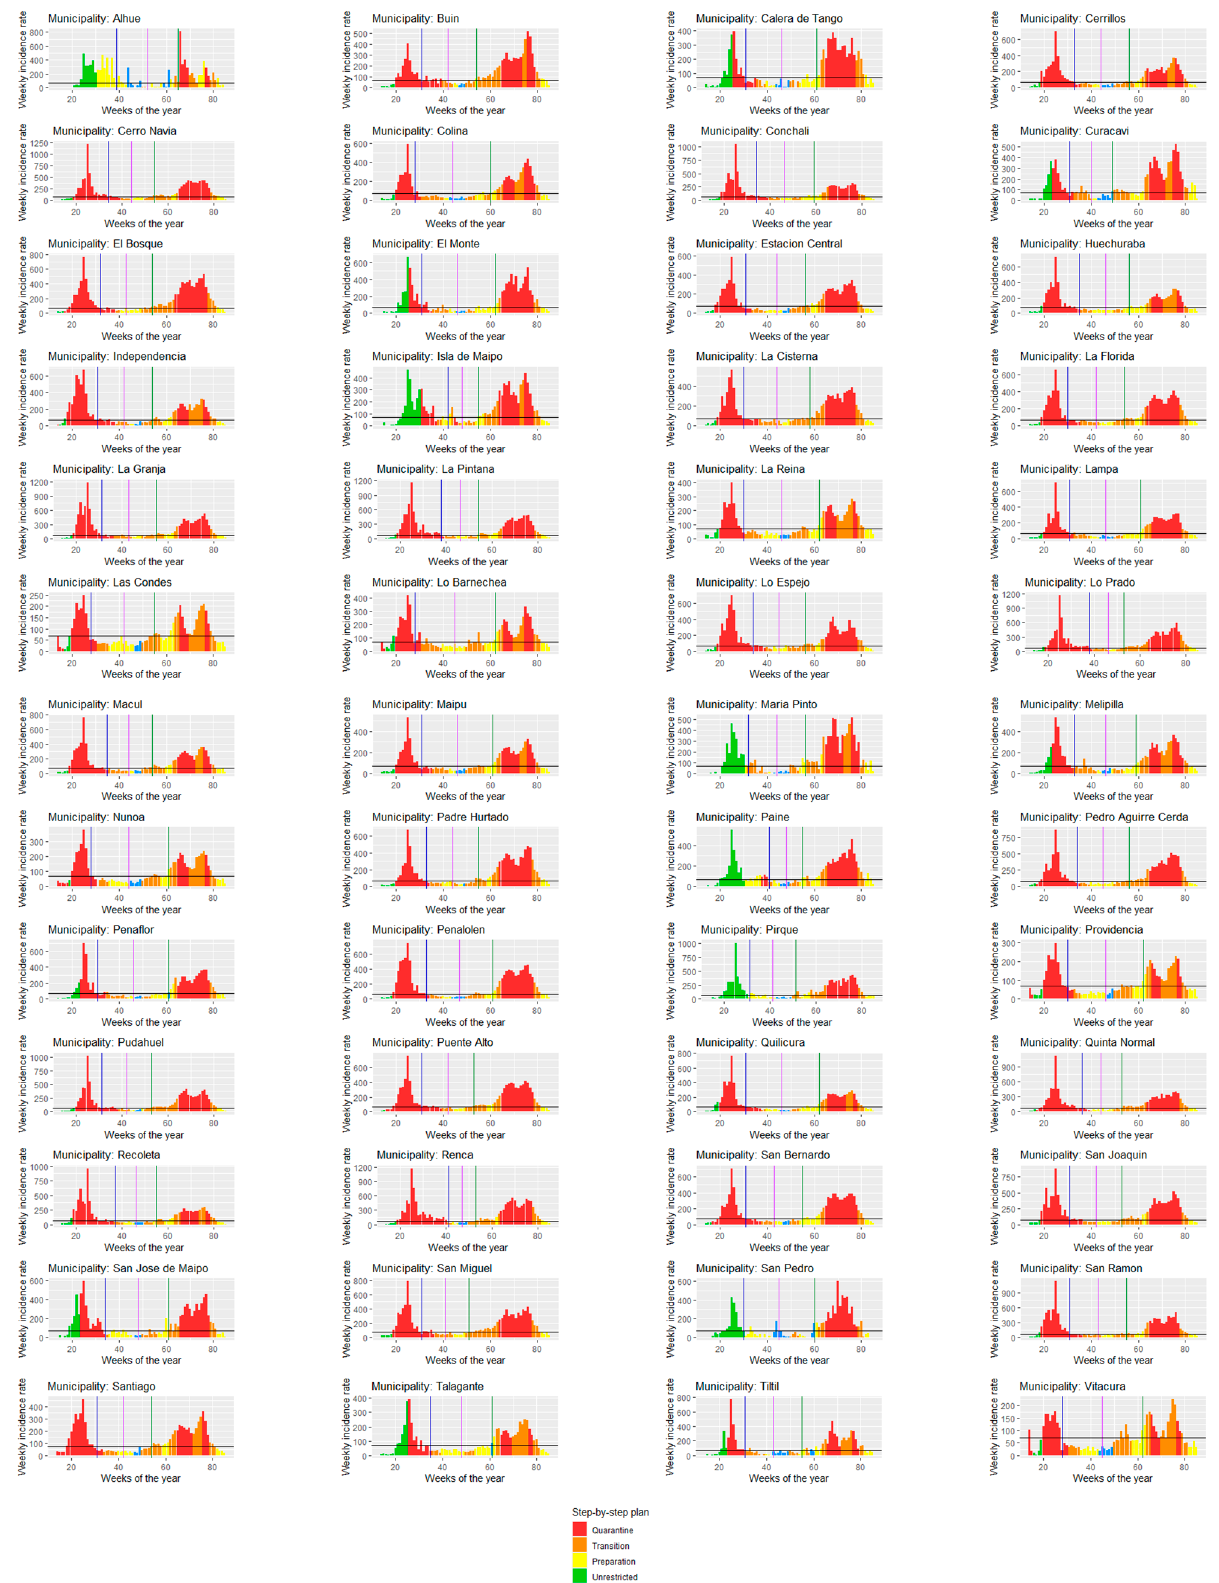
Figure 2. Cases, wave thresholds, and step-by-step stages in the Metropolitan Region.